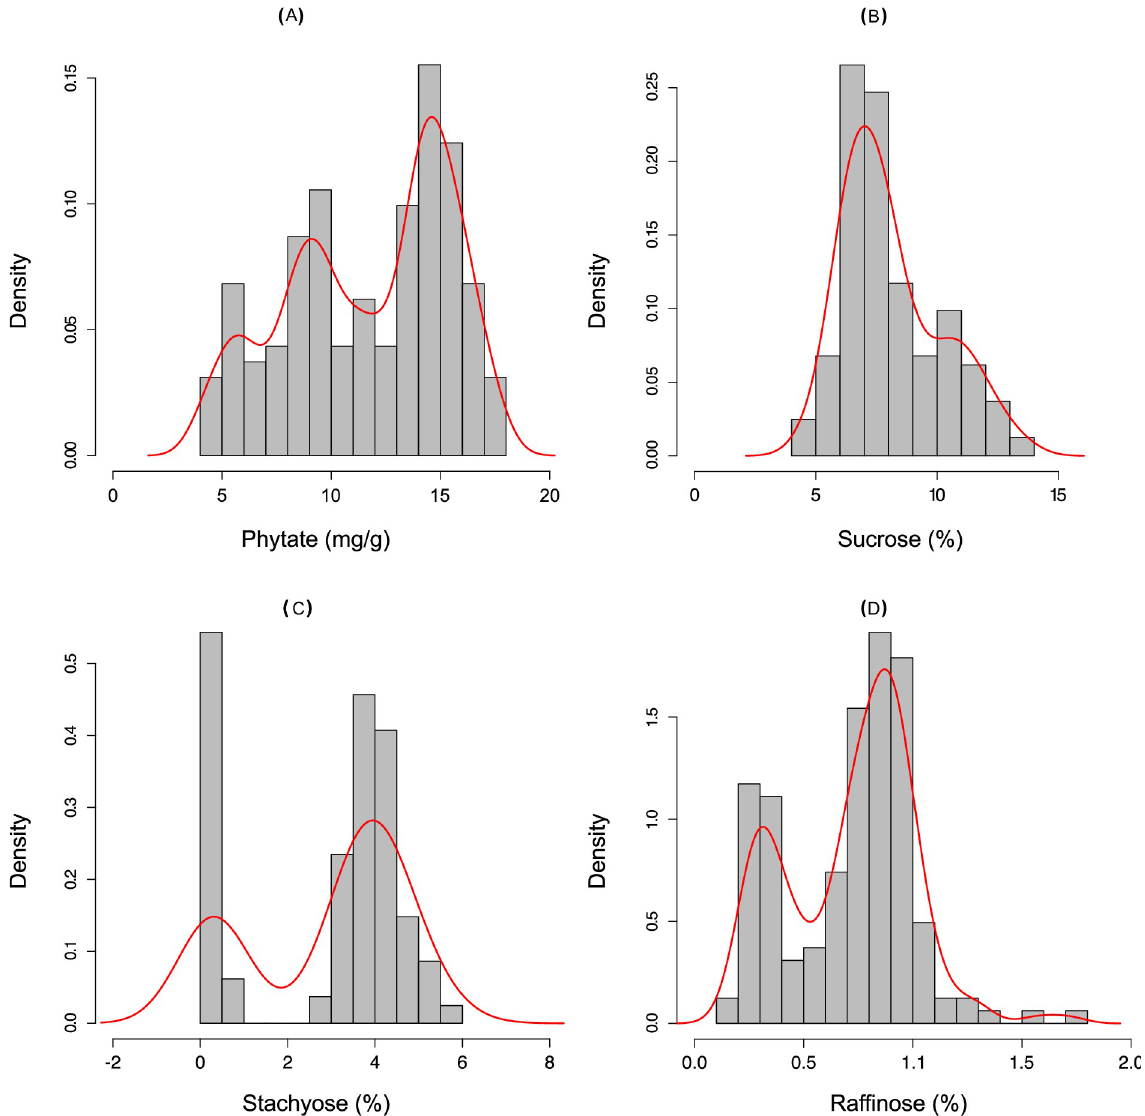
Fig 1. Distribution of seed phytate and oligosaccharide contents in the V99-5089 x CX1834 recombinant inbred population. Density plots represent data from RILs (N = 163) with homozygous alleles at three lpa causing mutational sites. (a) Phytate data was collected at the F 8 generation, whereas (b) sucrose, (c) stachyose, and (d) raffinose data were collected at the F 6 generation. Gaussian kernel density estimation for each of these datasets is indicated in red. The oligosaccharide (sucrose, raffinose, stachyose) contents are represented as percentage of dry seed